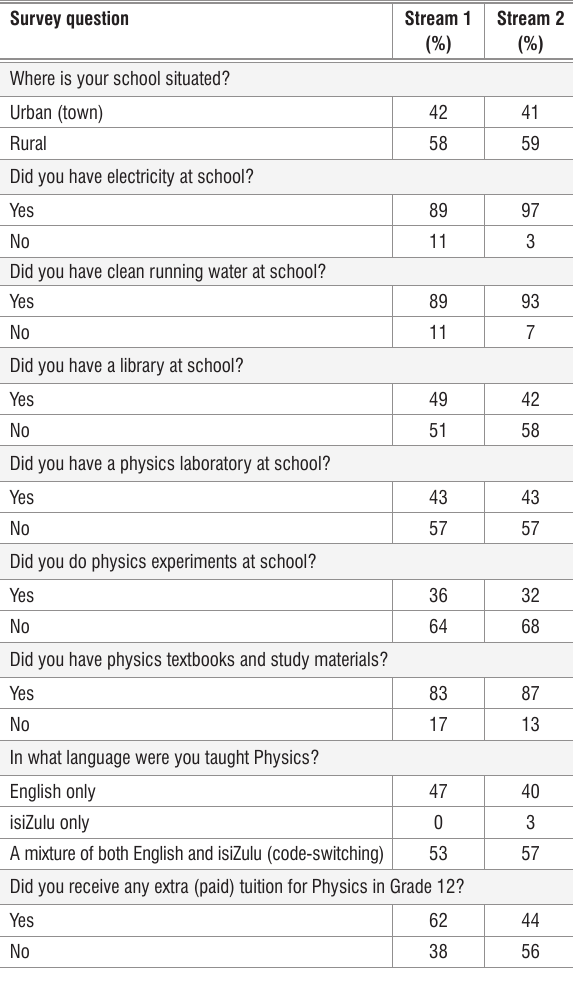
Student responses to questions on their personal environment